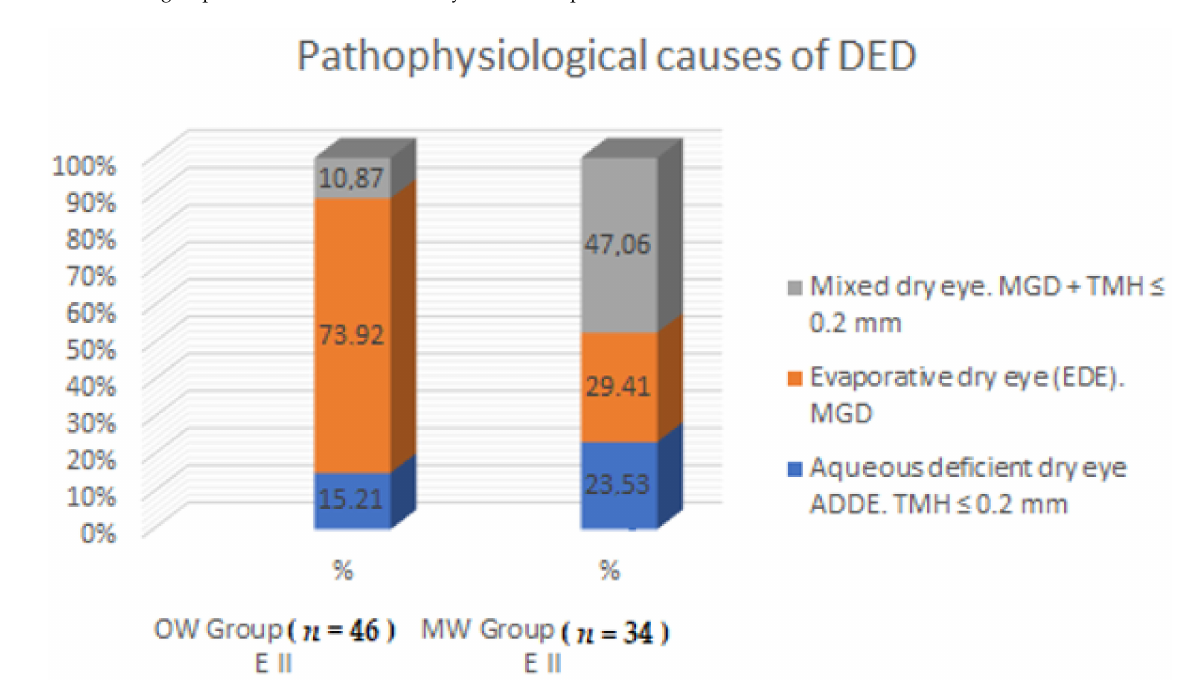
Pathophysiological Causes of DED